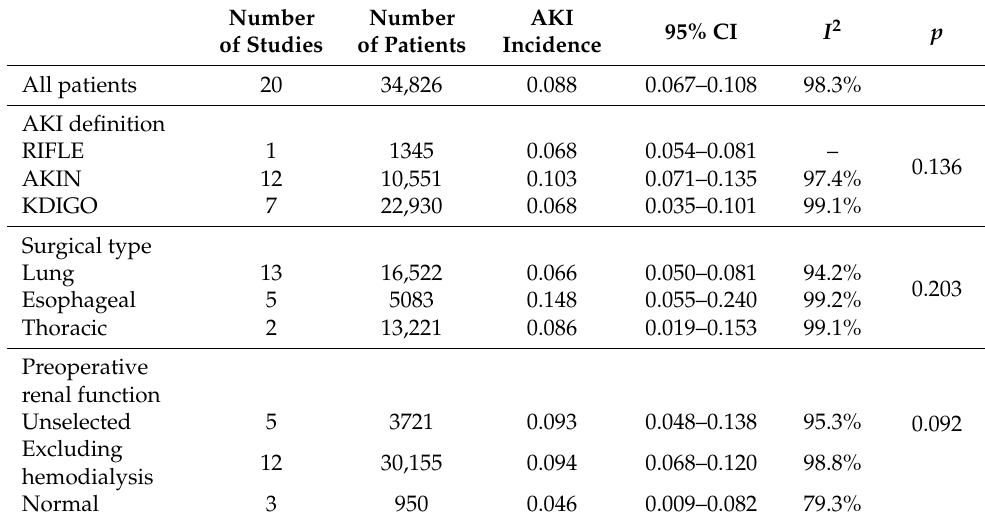
Table 2. Subgroup analysis of the proportion of patients who developed postoperative AKI.